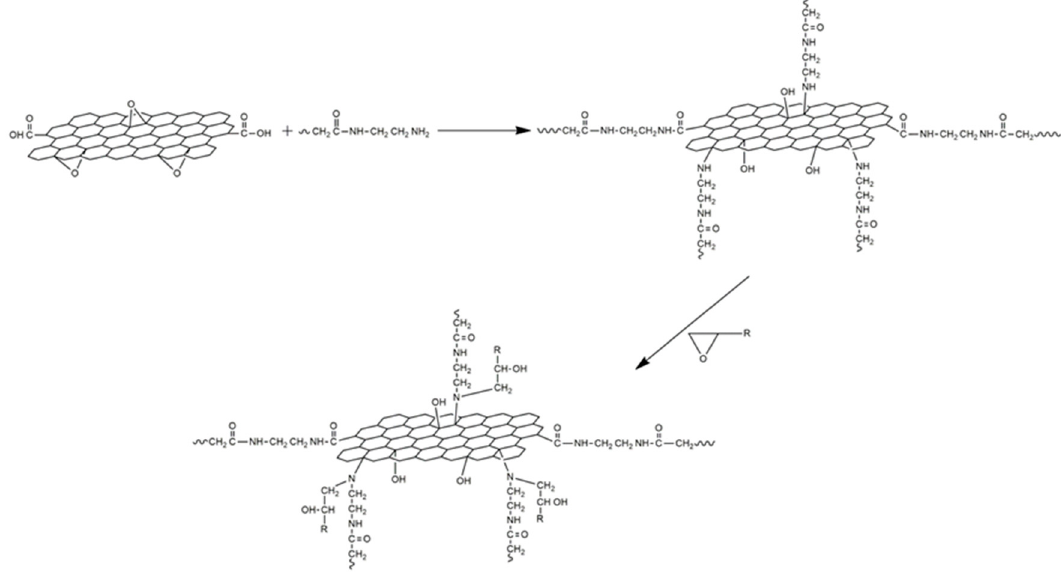
Figure 13. Proposed curing mechanism of GO- and rGO-modified epoxy systems .